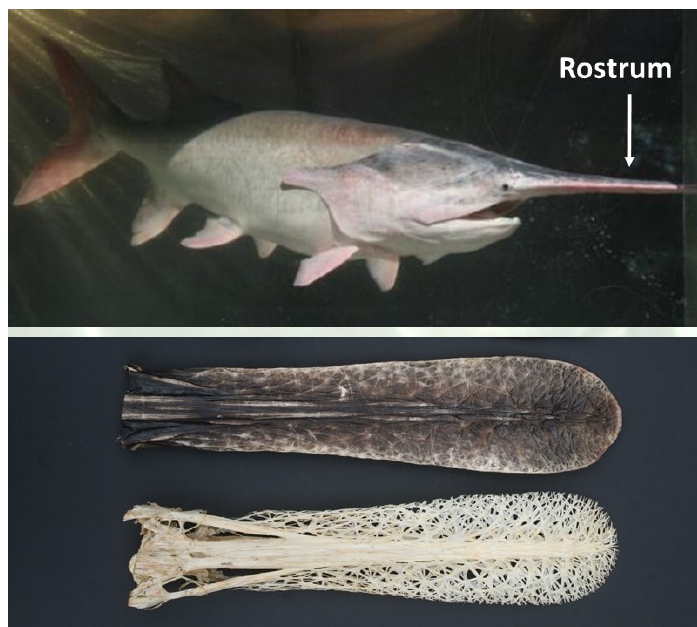
Figure 1. Paddlefish from the lower Mississippi River showing the unique rostrum of the species. (Upper photo) Adult fish 1 m long contained in a mobile swim tunnel; (lower photo) dried and skeletonized rostrum. Photo taken by Dr. Jan Jeffrey Hoover, USACE.